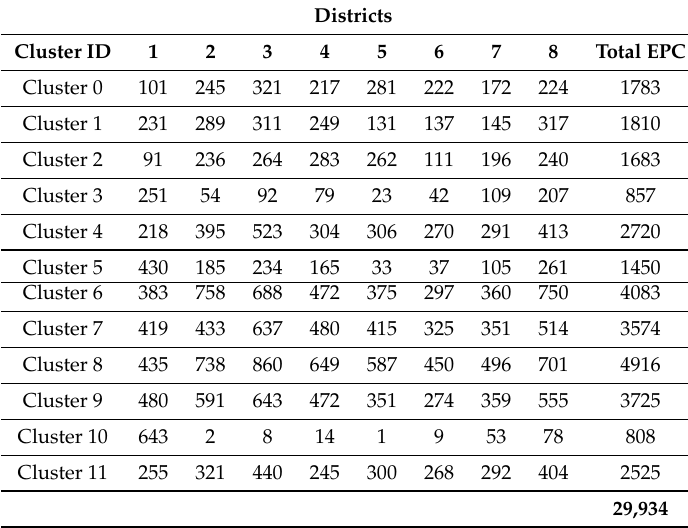
Table 3. Cardinality of the cluster set, separated for each